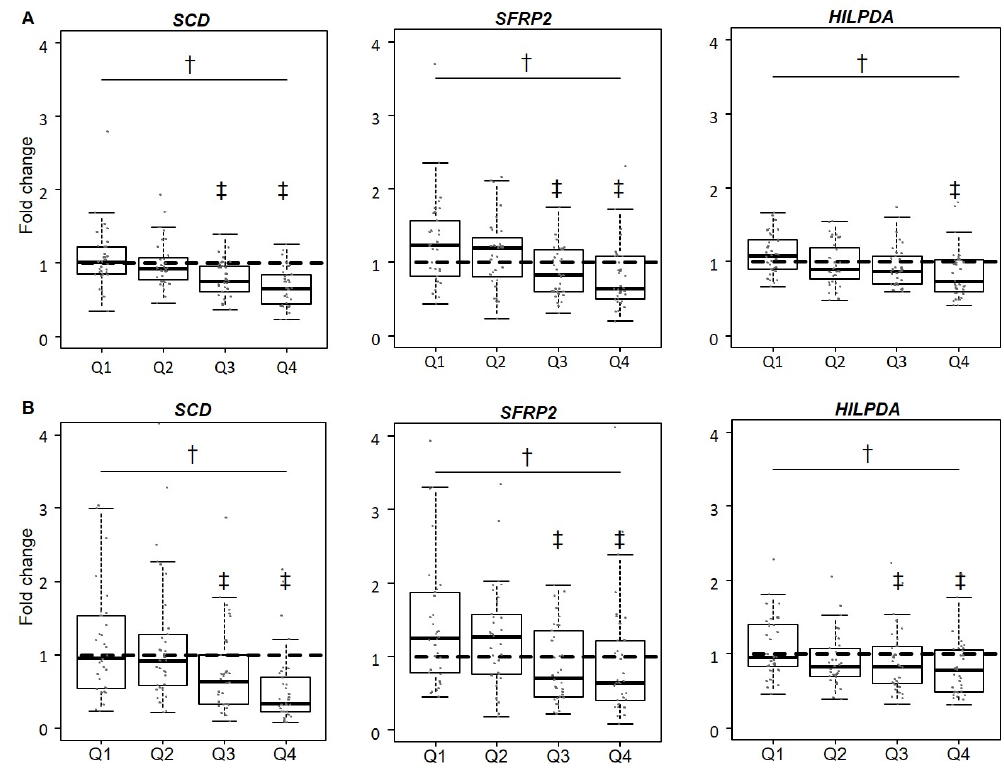
Figure 2. Effect of weight loss on SAT mRNA gene expression (microarray and RT-qPCR) of stearoyl-CoA desaturase ( SCD ), secreted frizzled-related protein 2 ( SFRP2 ), and hypoxia inducible lipid droplet-associated protein ( HILPDA ). ( A ) Relative gene expression across weight loss quartiles (Q1: lowest quartile) determined by microarray ( n = 138) is expressed as fold change (FC) between baseline (T 0 ) and after 12 weeks (T 1 ) (FC = 2 (logT1 − logT0) ). ( B ) Expression profiles quantified by RT-qPCR ( n = 136) are presented as FC of the delta-delta CT method (2 − ∆∆ CT ). Data points with an FC > 4.2 are not plotted ( SCD : n = 2, SFRP2 : n = 1). Significant differences ( p < 0.05) are depicted by † for overall effects and ‡ for pairwise comparisons.